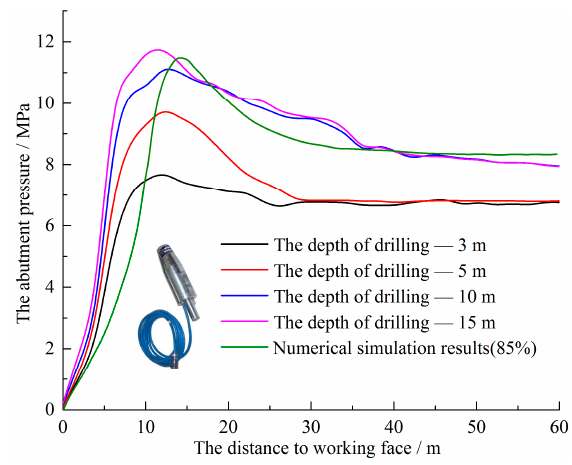
Figure 20. The abutment pressure in different depth of solid coal with the distance to working